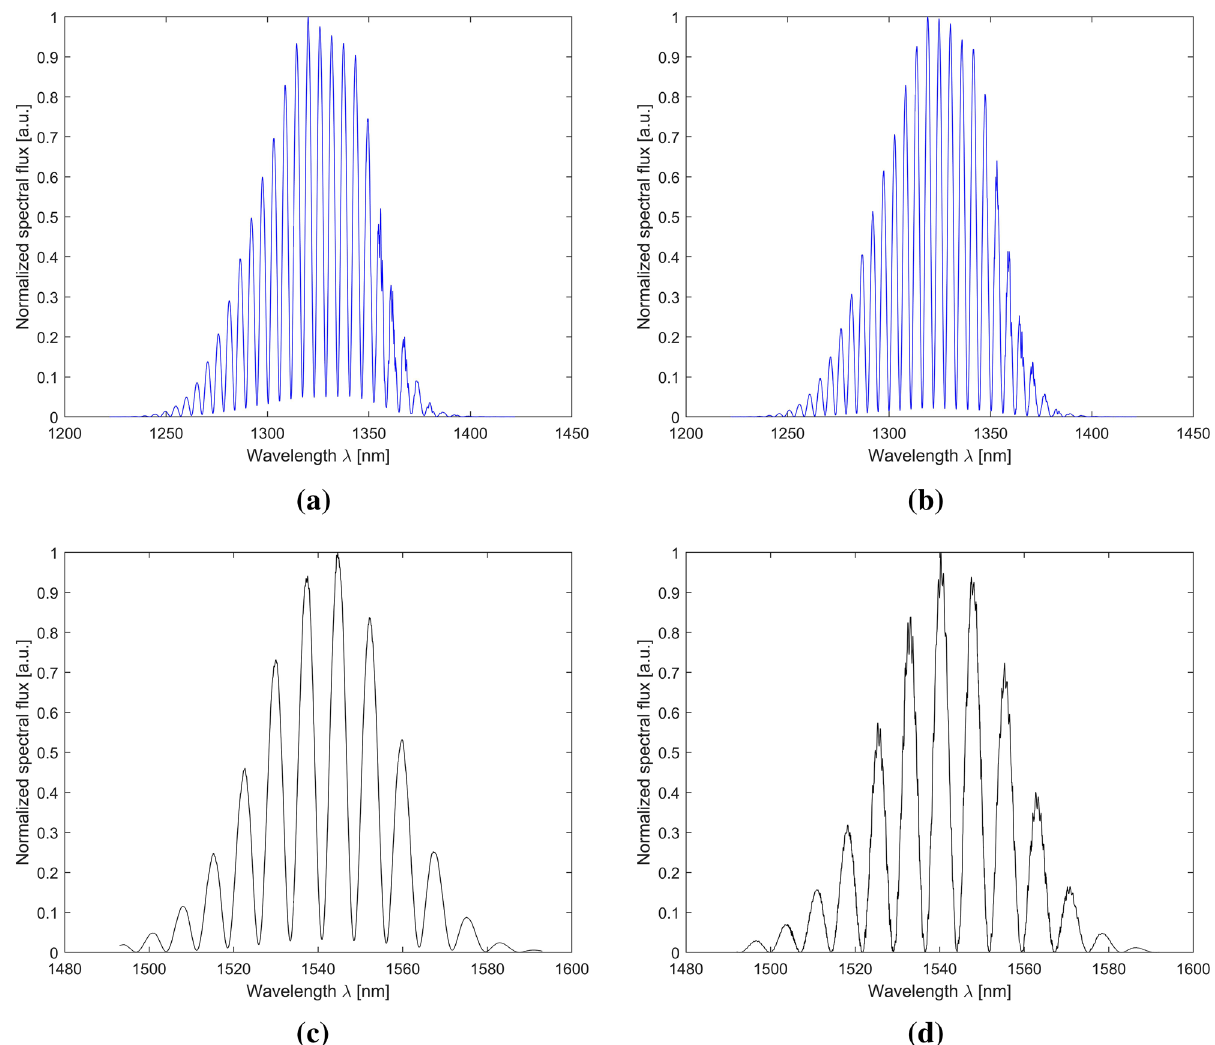
Figure 5. Selected optical characteristics measured for the cavity length of 150 μm on ( a ) the silver mirror for the wavelength of 1310 nm; ( b ) the SiN thin film for the wavelength of 1310 nm; ( c ) the silver mirror for the wavelength of 1550 nm; ( d ) the SiN thin film for the wavelength of 1550